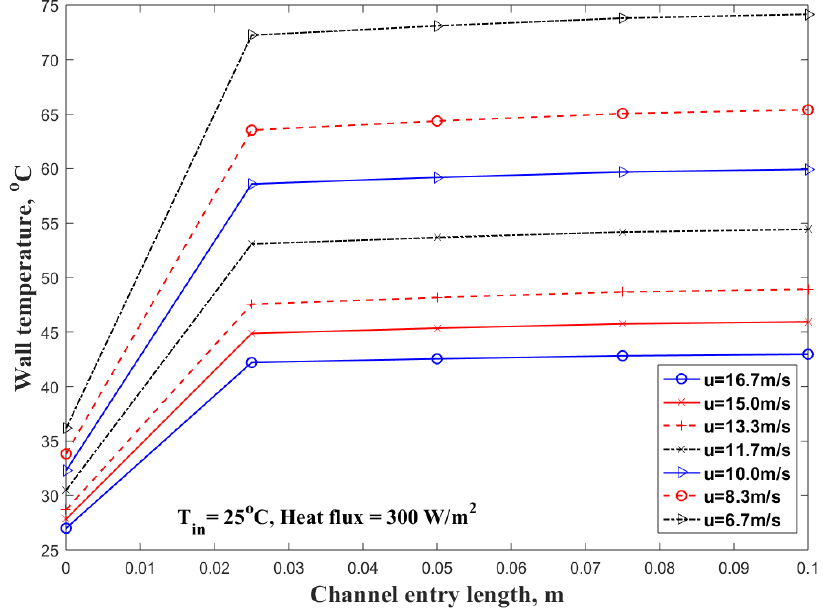
Figure 6. Effect of distance from the inlet on linear wall temperature profile at T = 25 °C and HFV of 300 W/sqm.